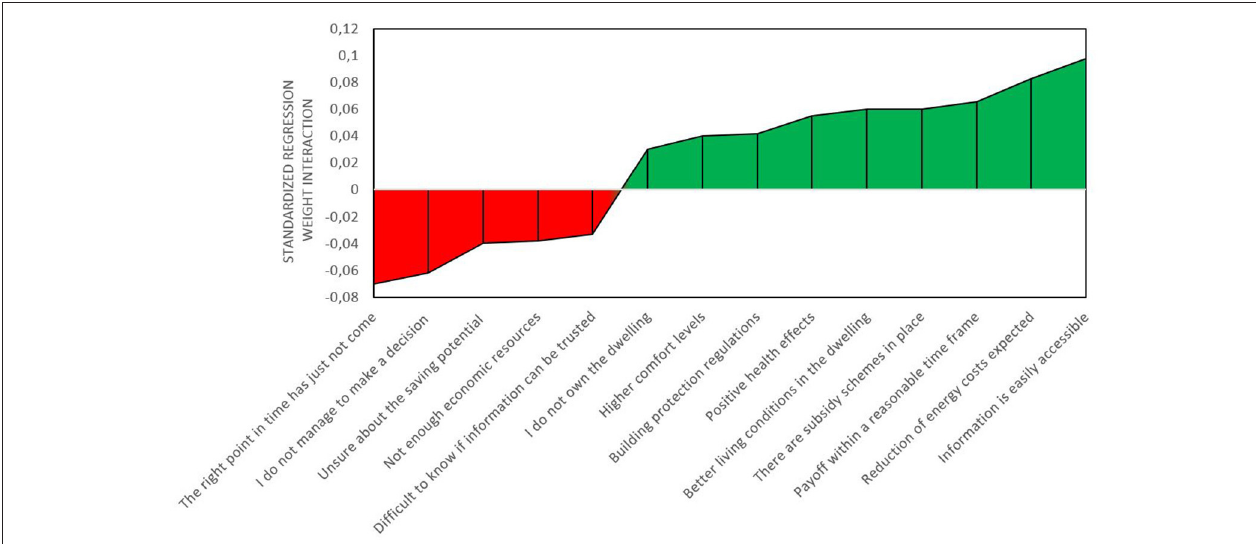
FIGURE 3 | Significant barriers and drivers for the transition from deciding what to do to deciding how to do it .